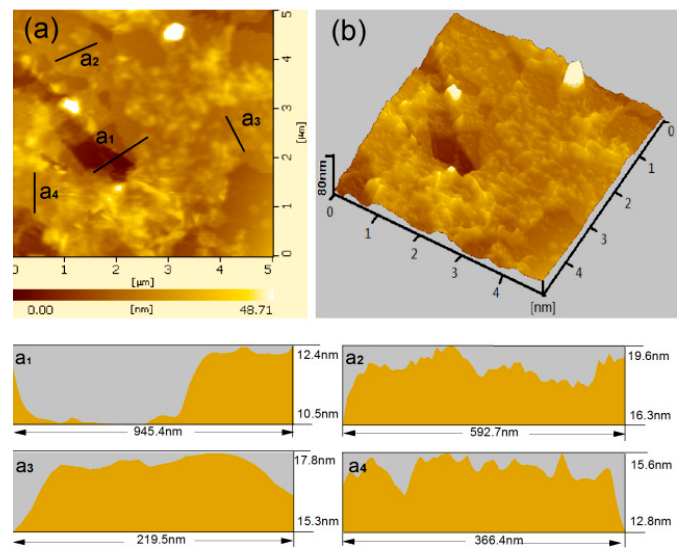
Figure 4. AFM images of GO sheets from the original GO suspension: ( a ) top view, ( b ) side view, ( a 1 , a 2 , a 3 , a 4 ) the side view of GO sheets at ( a 1 , a 2 , a 3 , a 4 ) in ( a ).